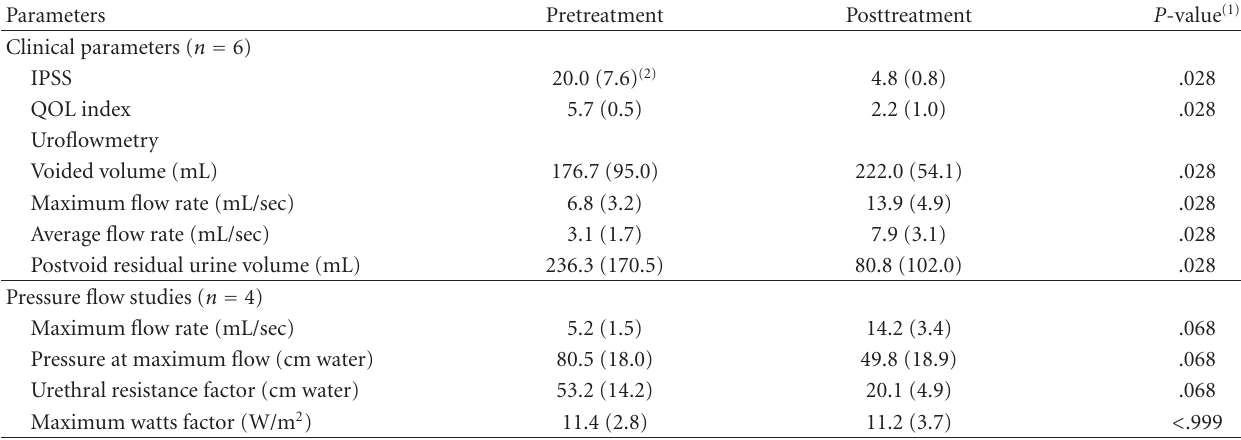
Table 2: Change in parameters after urethral dilatation in patients with bladder outlet